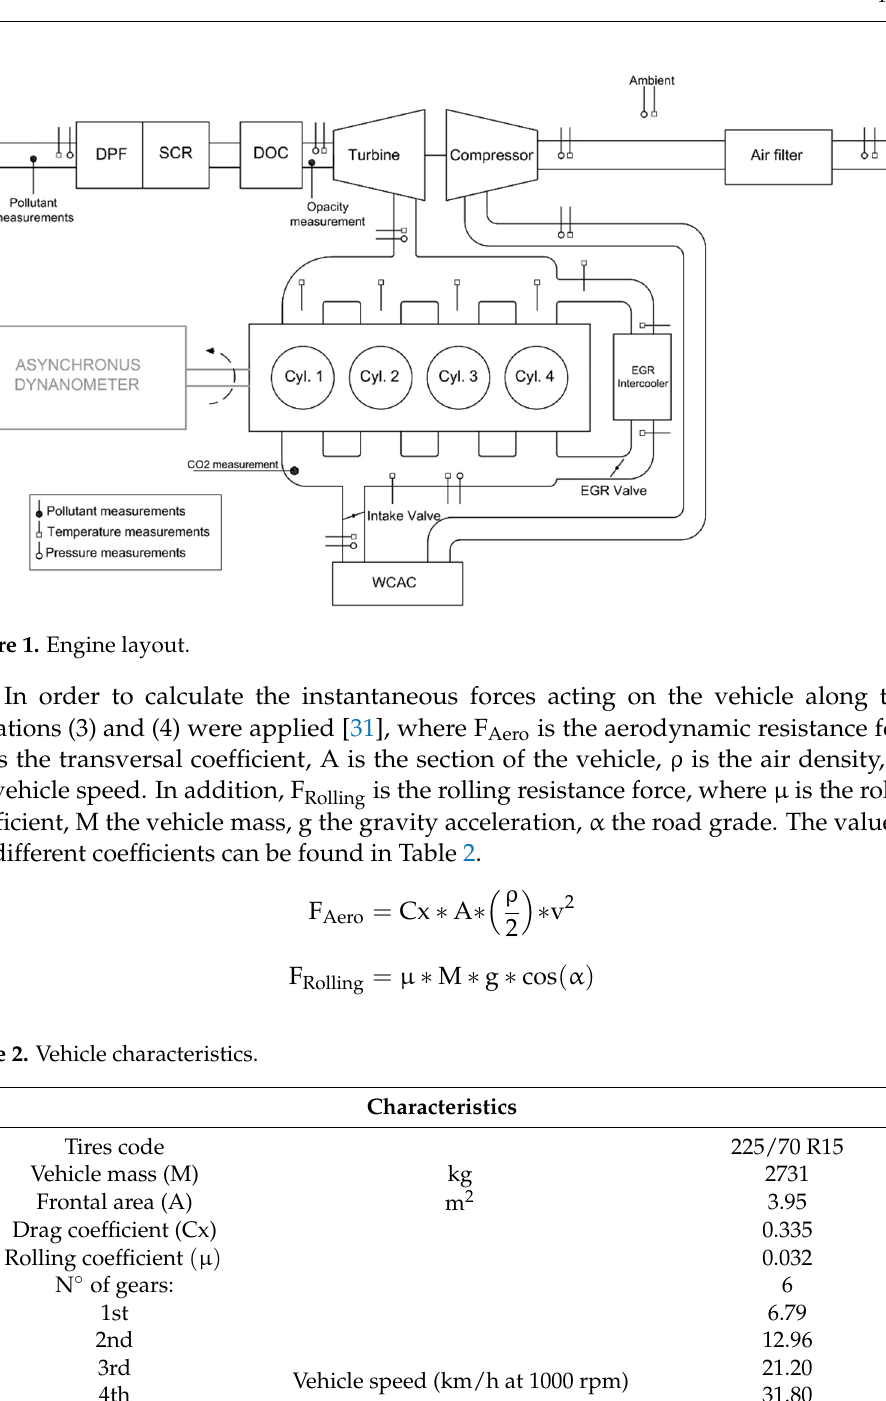
Table 2. Vehicle characteristics.